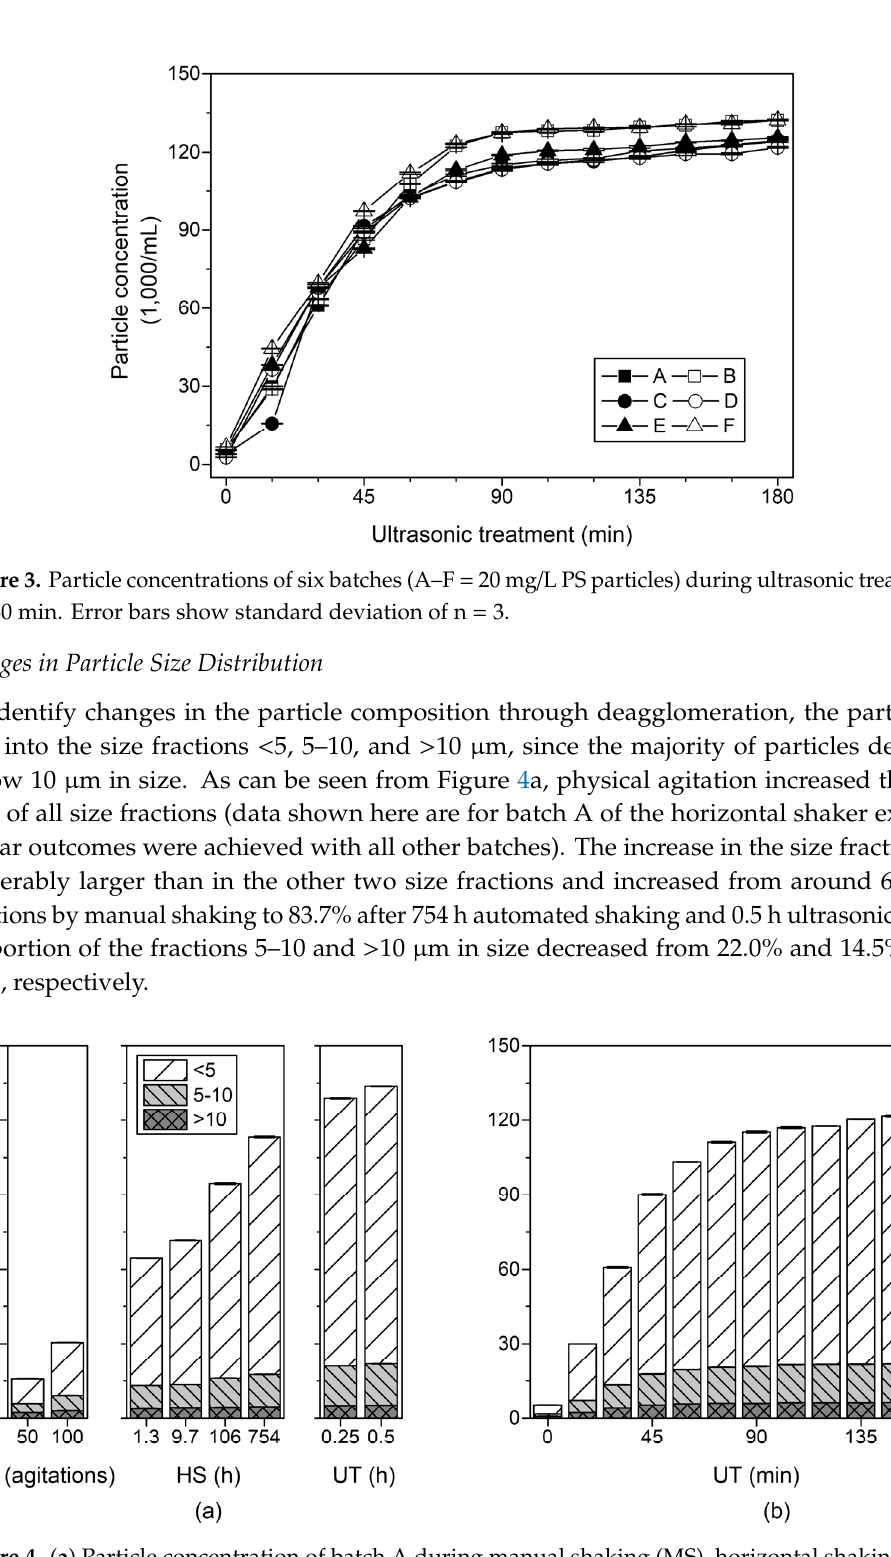
Figure 4. ( a ) Particle concentration of batch A during manual shaking (MS), horizontal shaking (HS) and ultrasonic treatment (UT). ( b ) Particle concentration of batch A (20 mg / L PS particles) during ultrasonic treatment (UT) for 180 min. Particles in all diagrams were grouped in size fractions < 5 µ m, 5–10 µ m and > 10 µ m. Error bars show standard deviation of n = 3.